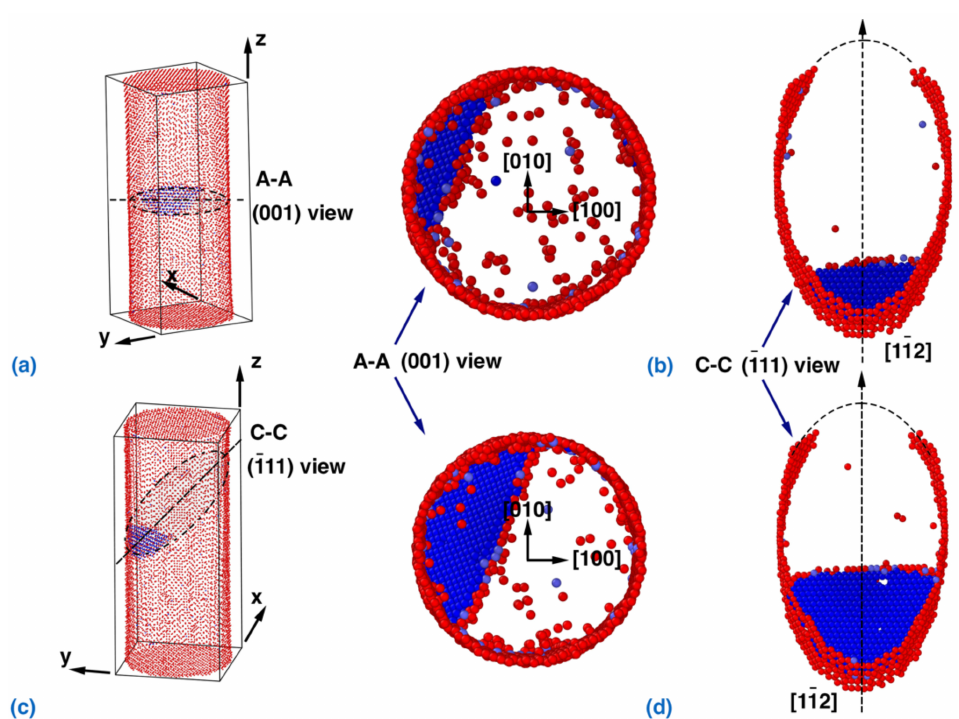
Figure 4. Dislocation nucleation and slip in the NW with a torsion/tension strain ratio of 0.7265. View of the dislocation nucleation from: ( a ) cross-sectional view, i.e., the (001) plane, and ( b ) the (111) plane. Below, a view of the propagation of the partial dislocation that forms stacking faults with trailing partial dislocations pinned at the surface; ( c ) cross-sectional view and ( d ) the (111) plane. Atoms with the Ackland–Jones parameter (AJP) [56] equal to 0 and 3 are visualized in order to distinguish the atoms in the surface and partial dislocation/stacking faults,